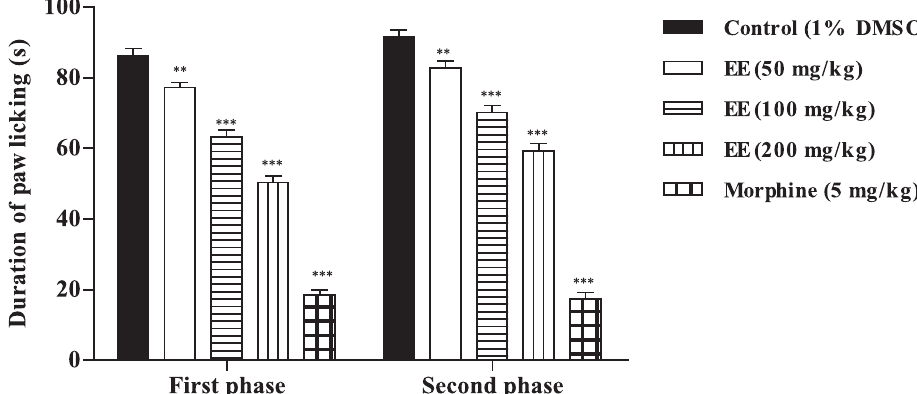
Figure 2 - Effects of the ethanol extract from A. fastigiatum branches on formalin-induced nociception in mice. First phase = 0-5 min after formalin injection; second phase = 15-30 min. The experimental groups were pre-treated 60 minutes previously to the beginning of experiment. EE, ethanol extract.